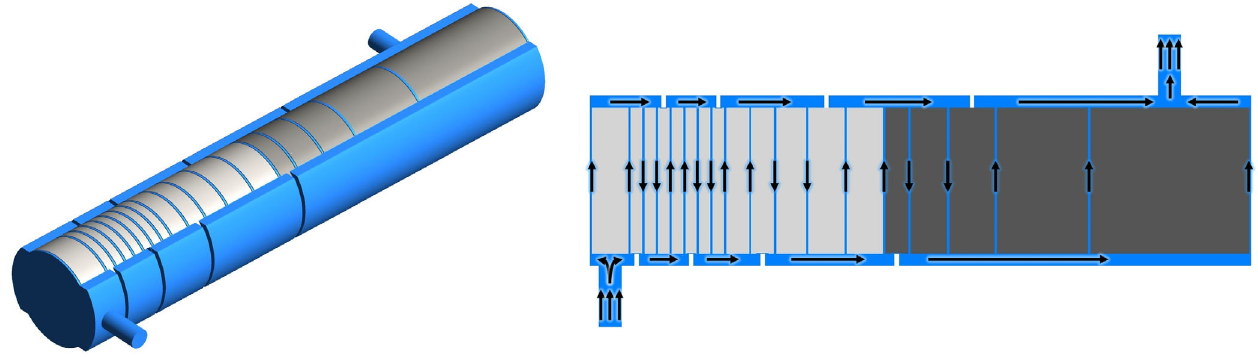
FIG. 8. 3D model of the BDF target cooling circuit and longitudinal cross section (top view). The water flow is distributed by the manifolds (located in the left and right side of the target) to the 5 mm water channels between the target blocks. The serpentine configuration with two parallel streams (three for the last channels) can be